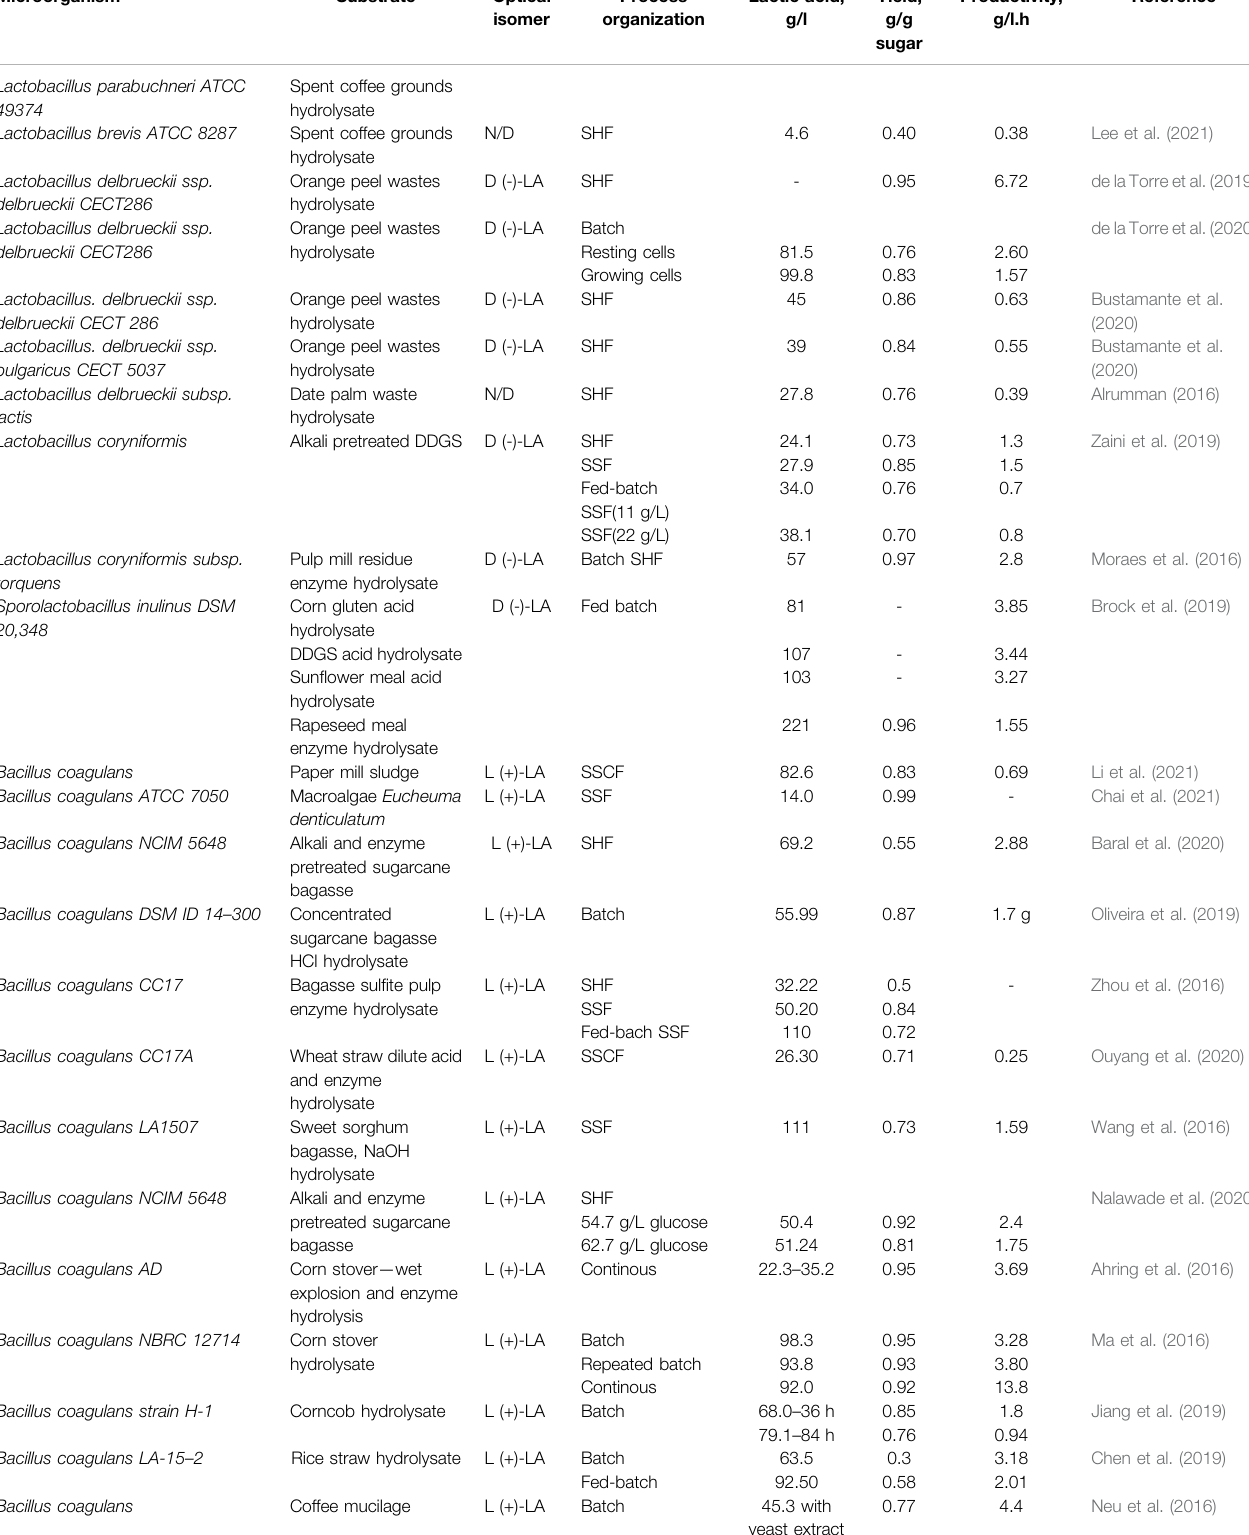
TABLE 4 | ( Continued ) Microorganisms, substrates, and lactic acid yield and productivity from different feedstocks.